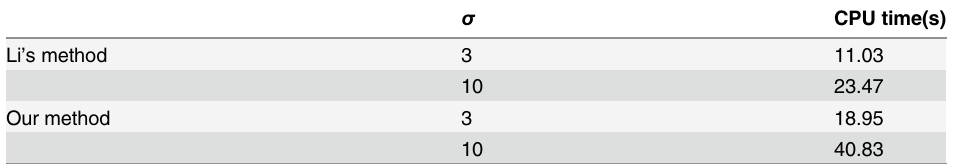
Table 2. Comparison the CPU time of Li ’ s method and our method for Fig.